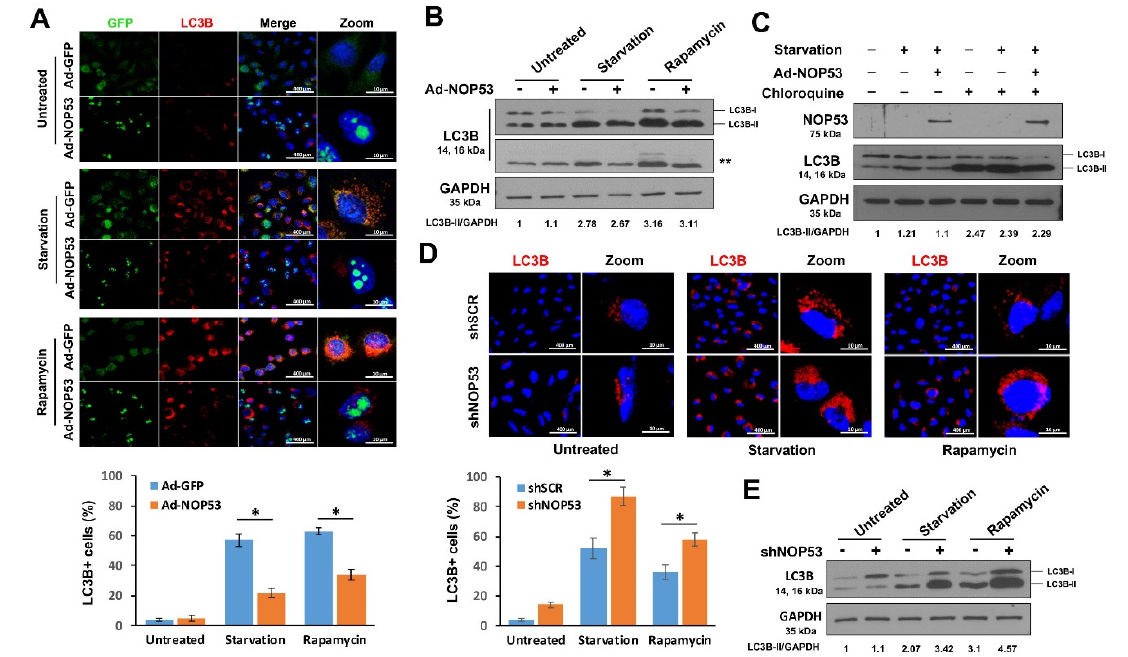
Figure 1. NOP53 suppresses the autophagic flux. ( A ) LN18 cells were untreated or transduced with Ad-GFP or Ad- NOP53/GFP, followed by starvation in EBSS medium for 24 h or treatment with 10 ng/mL rapamycin for 12 h, and immunocytochemical staining with anti-LC3B antibody was performed (upper three panels). Cells with formations of more than 5 LC3B spots were counted, and the ratio is presented (lower panel). Data from three independent experiments are shown as the means ± SD; * p < 0.01. ( B ) Cells lysates treated as in “A” were subjected to Western blotting using the anti-LC3B antibody after normalization to GAPDH . **, short exposure. ( C ) Cells were treated as indicated in the presence or absence of chloroquine (50 µ M) for 3 h, and the lysates were subjected to western blot using anti-NOP53 or anti-LC3B antibody after normalization to GAPDH . ( D ) shSCR and shNOP53 cells were untreated, starved in EBSS medium, or treated with rapamycin, as in “A”, and immunocytochemical staining was carried out using the anti-LC3B antibody (upper panels). The cells with LC3B spot formation were counted, and the ratio is presented (lower panel). Data from three independent experiments are shown as the means ± SD; * p < 0.01. ( E ) shNOP53 cells were untreated, starved, or treated with rapamycin, and then, Western blotting was performed using the indicated antibody. LC3B-II or GAPDH expression using Western blotting was quantified using ImageJ software. The LC3B-II/ GAPDH ratio was normalized to the control.